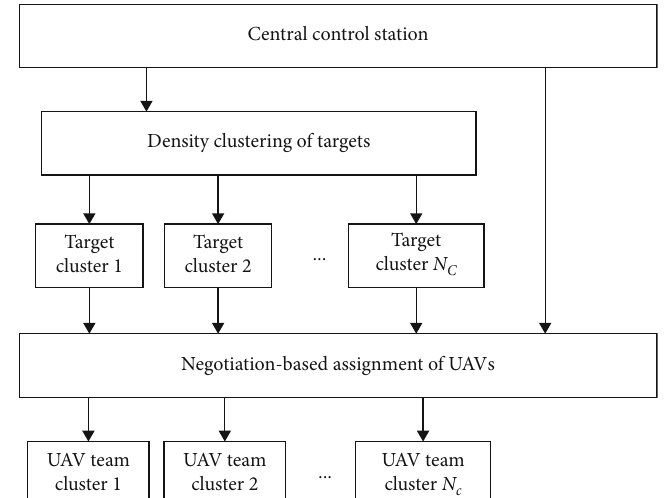
Figure 2: MDA-DCNM.